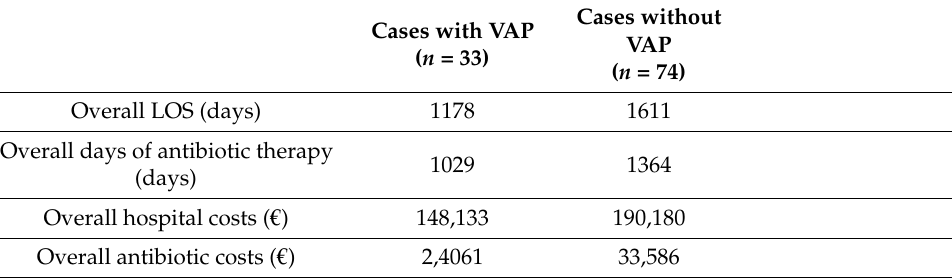
Table 3. Financial impact attributed to ventilator-associated pneumonia: additional costs for